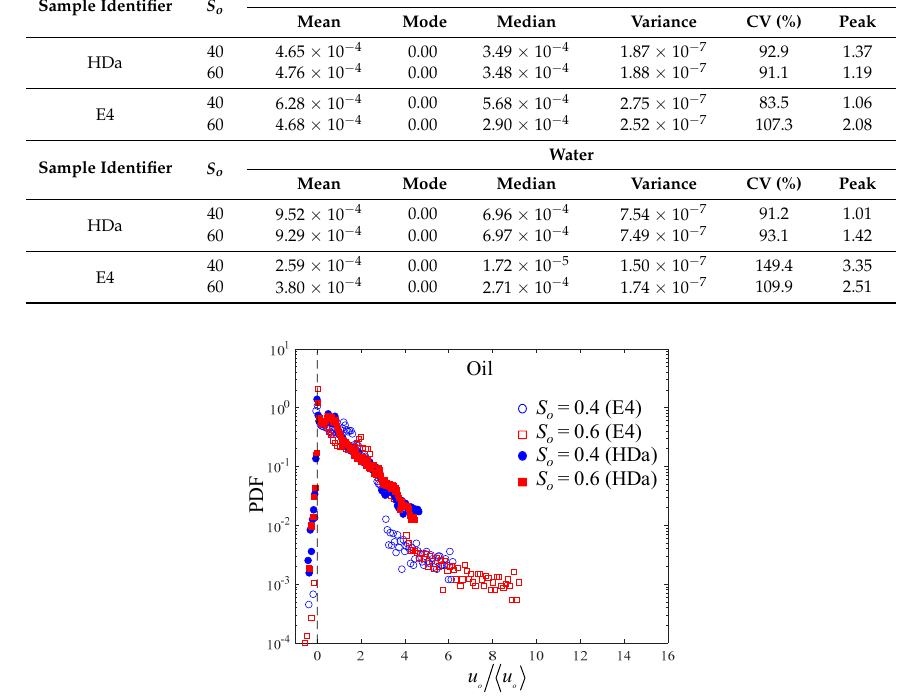
Table A1. Mean, mode, median, variance and the coefficient of variation (CV) of u α ( α = o or w ). Peak values of the sample probability distributions (PDFs) of u α / (cid:104) u α (cid:105) are also included.